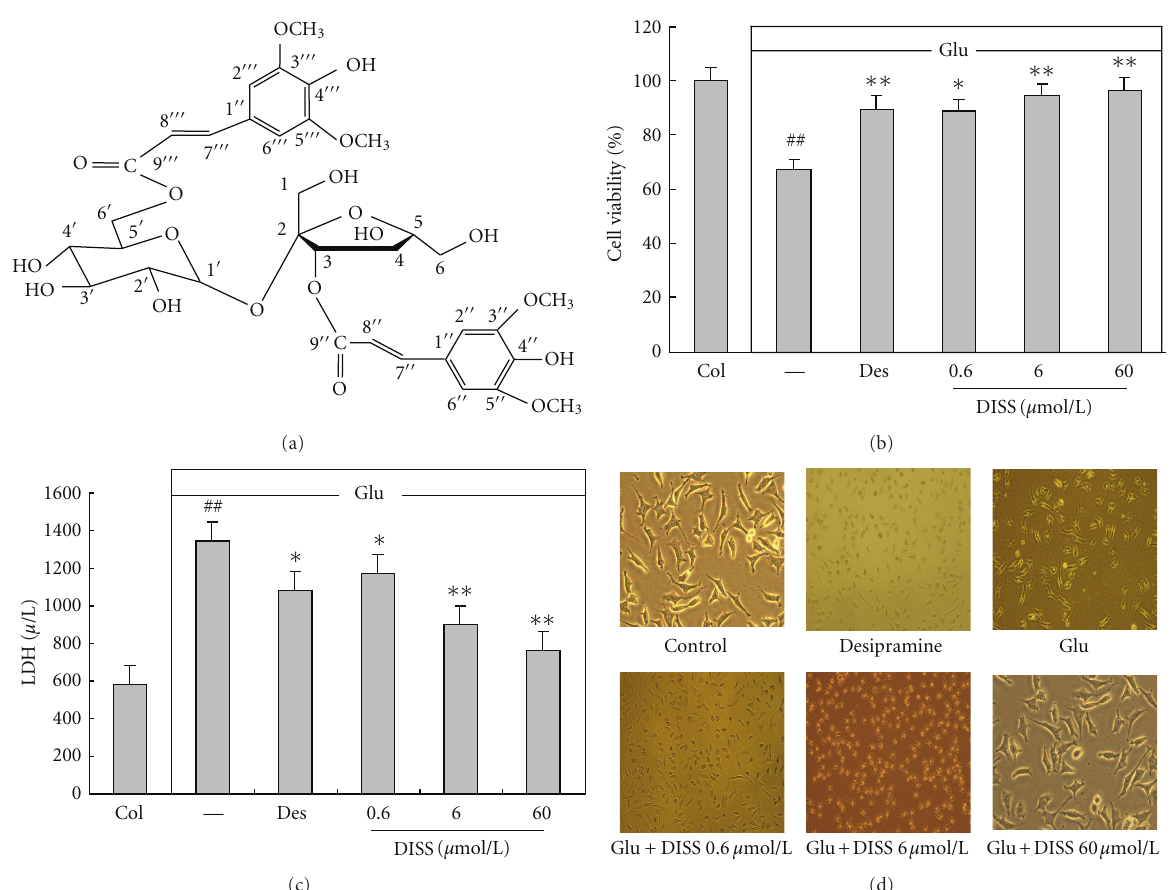
Figure 1: Protective e ff ects of DISS on glutamate- (Glu-) induced cytotoxicity in SH-SY5Y cells. (a) Chemical structure of 3,6 (cid:2) -disinapoyl sucrose (DISS). (b) E ff ects of DISS treatment on SH-SY5Y cells viability decrease induced by glutamate (8mM) exposure. (c) E ff ects of DISS treatment on lactate dehydrogenase (LDH) release of SH-SY5Y cell damaged by glutamate. (d) E ff ect of DISS on glutamate- (Glu-)induced morphological alterations in SH-SY5Y cells. All data were expressed as mean ± S.D. of three experiments. ## P < 0 . 01, compared with normal cultures; ∗ P < 0 . 05, ∗∗ P < 0 . 01 compared with Glu alone group. Co: Control; Des: desipramine, which is positive